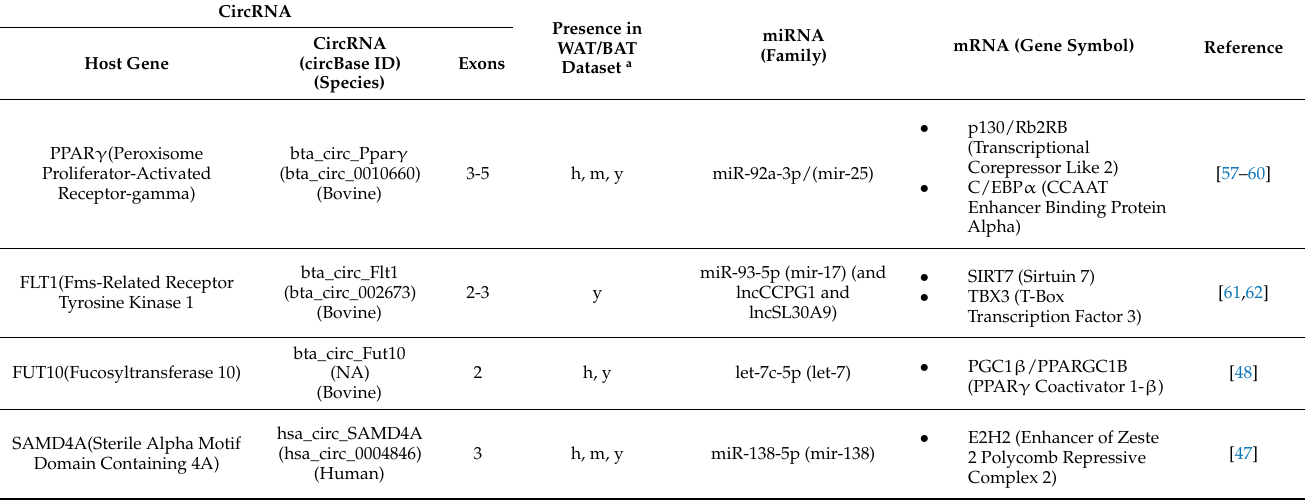
Table 3. Validated circRNA–miRNA–mRNA connections in preadipocyte